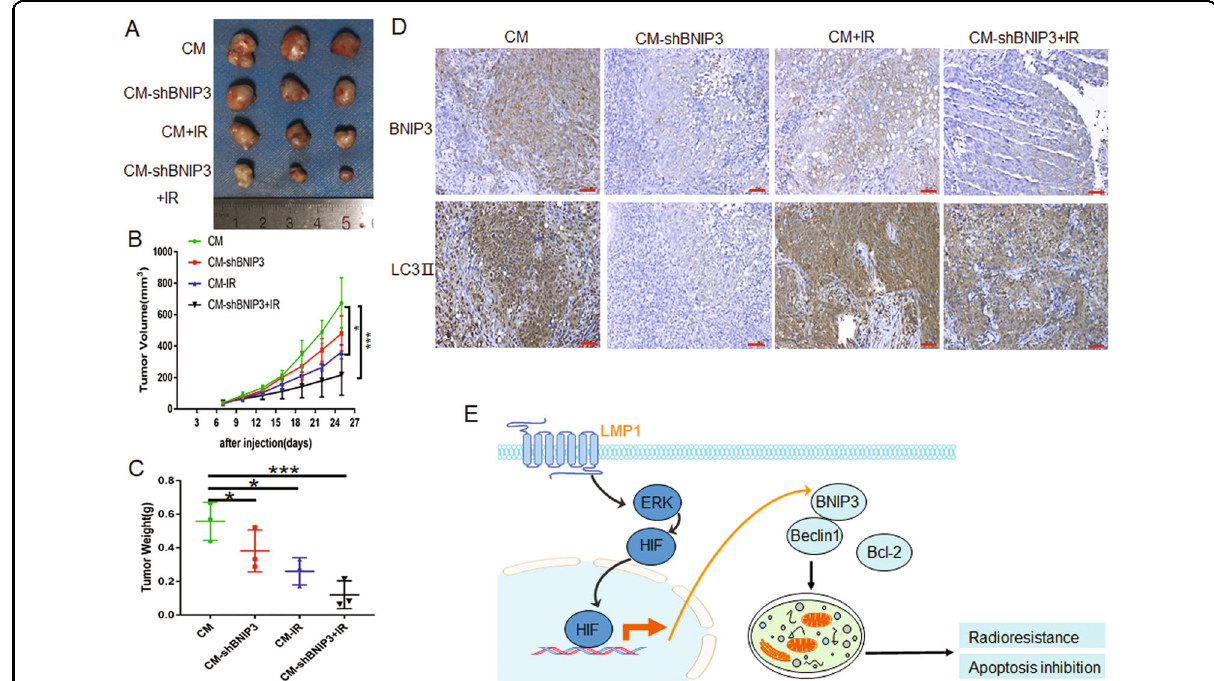
Fig. 7 LMP1-induced BNIP3 increases radioresistance of NPC in vivo. The xenograft model was established using CM cells or CM-shBNIP3 cells. When the tumor volume reached 60 – 100 mm 3 , 6 Gy local irradiation was administered. A At the experimental end point, tumor xenografts were dissected and photographed. B Tumor volume was measured every 3 days after injection. C Tumor weight was measured at the experimental end point. * p < 0.05, *** p < 0.001. D Representative immunohistochemistry (IHC) staining of BNIP3 and LC3II expression in CM xenografts in the groups indicated in A . Scale bar: 50 μ m. E A schematic illustration of the LMP1 promoting radioresistance by inducing autophagy through ERK/HIF1 α /BNIP3 in